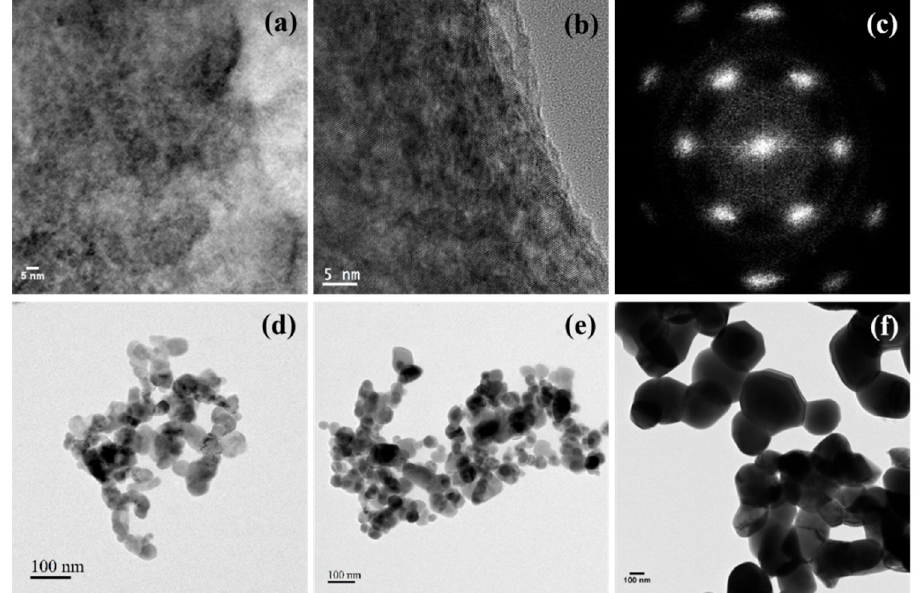
Figure 5. ( a ) Bright field TEM image of the as-prepared ZnO nanoparticles before annealing, ( b ) TEM image of the same ZnO sample annealed at 80 °C, ( c ) Diffraction of ZnO NP seen in ( b ), ( d–f ) TEM images of the annealed samples 150, 250, and 800 °C respectively. The scale bar in images ( a – b ) is 5 nm and in ( d–f ) is 100 nm.